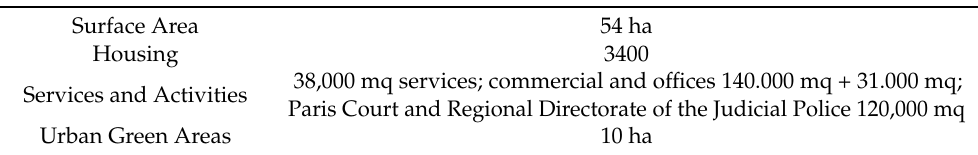
Table 14. The project. Source: Authors’ elaboration (2022) based on data from the site http://www. ecoquartiers.logement.gouv.fr (accessed on 19 June